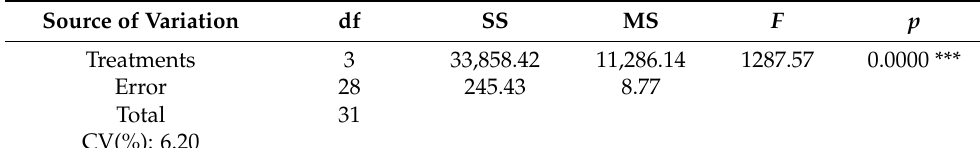
Table 3. Analysis of variance of the in vitro antagonism effect of Trichoderma species against Pyricularia oryzae Triticum lineage.